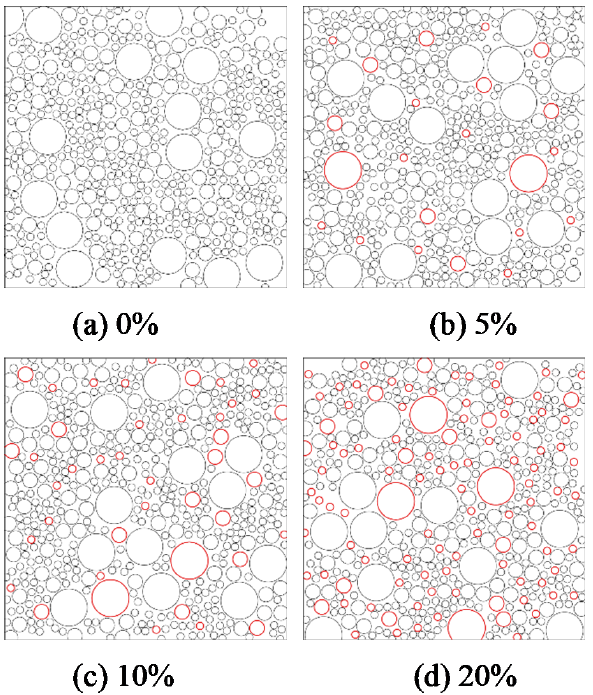
Table 6. Mechanical property parameters of HTPB propellant containing interface defects. Figure 8. Mesoscale model of propellant with different interface defect contents.